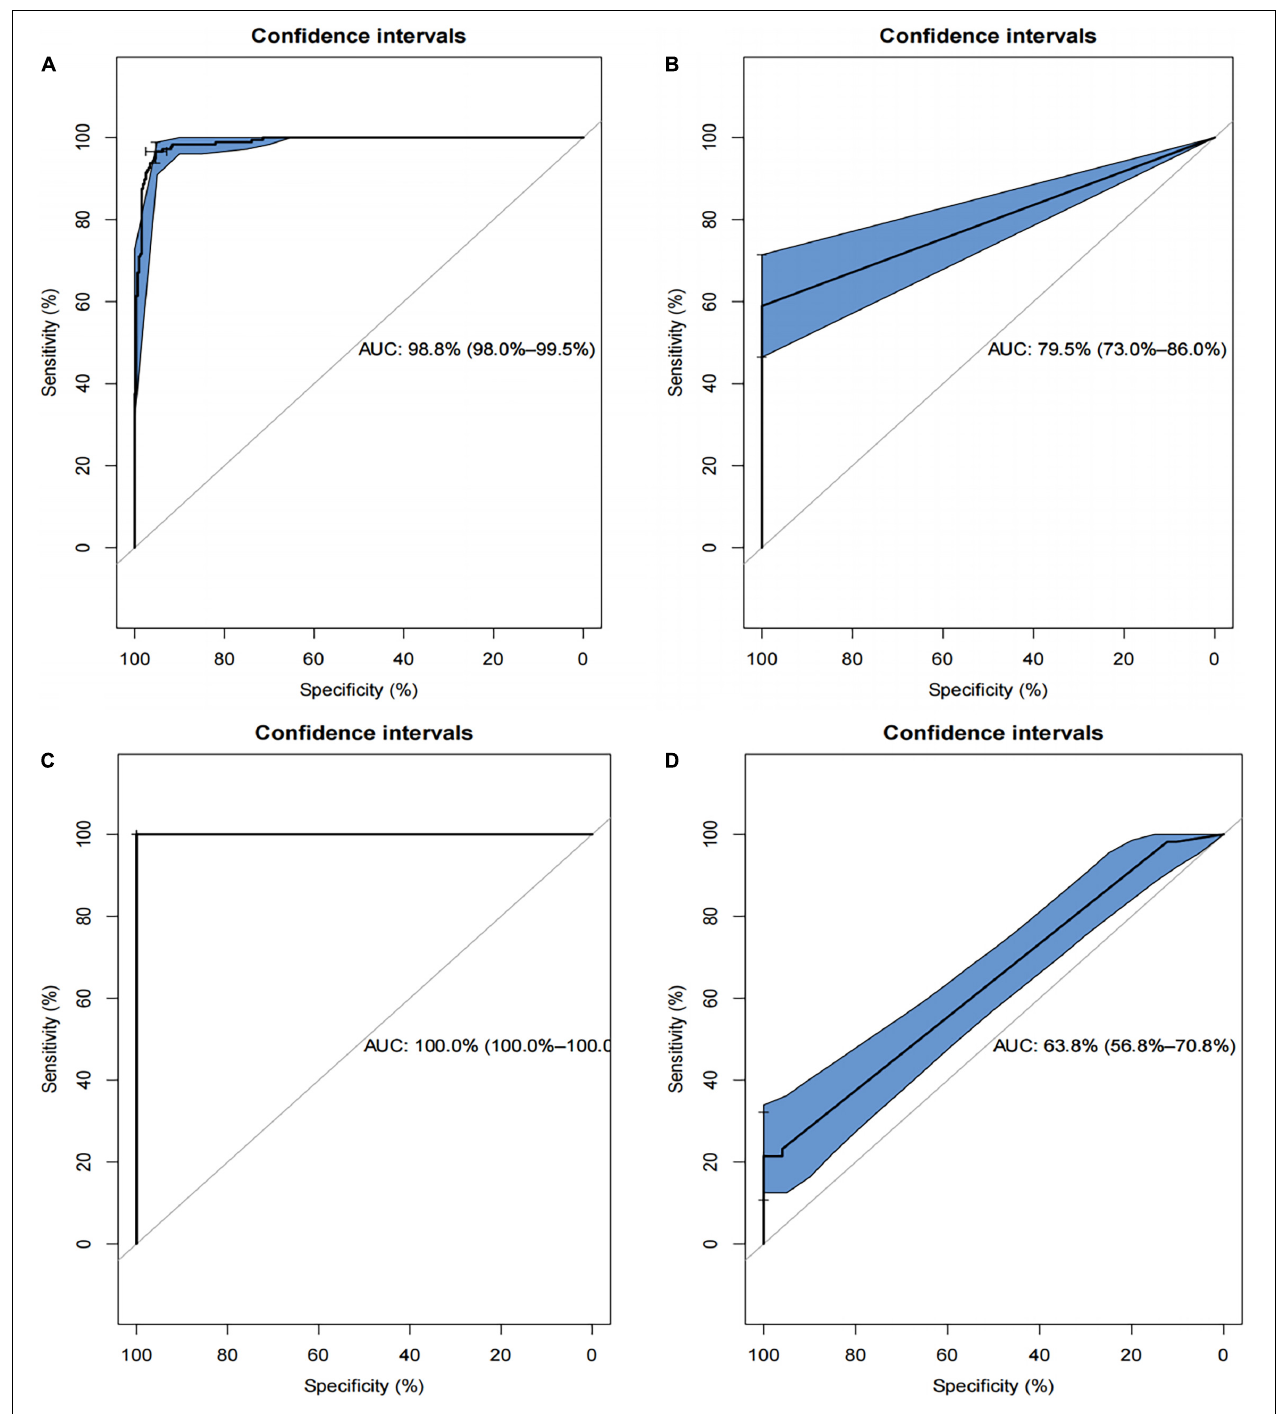
FIGURE 8 | Receiver operating characteristics (ROCs) curve for the SVM-based and the XGBoost-based model in the training and test datasets. (A) The ROC curve for SVM-based model in training set; (B) the ROC curve for SVM-based model in test set; (C) the ROC curve for XGBoost-based model in the training set; (D) the ROC curve for XGBoost-based model in the test